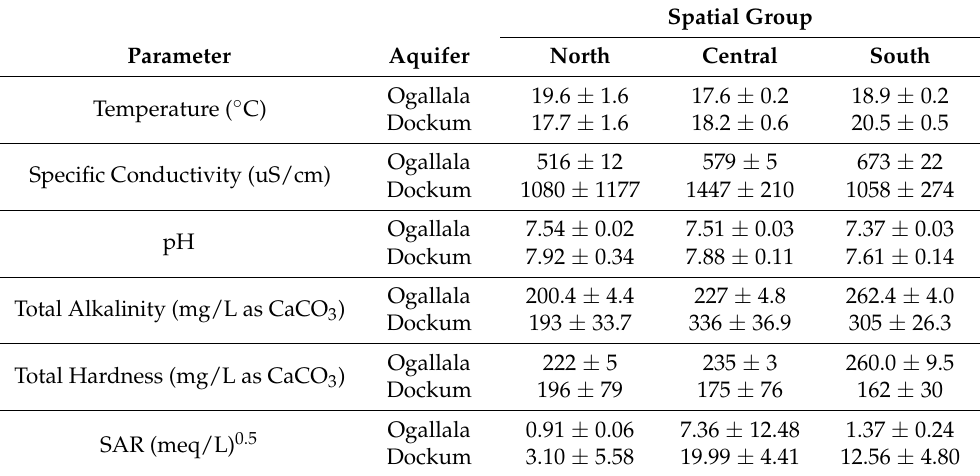
Table 3. Aggregate water quality parameters for aquifers according to spatial groups from 1990 to 2021. Values shown are mean ± 95% confidence